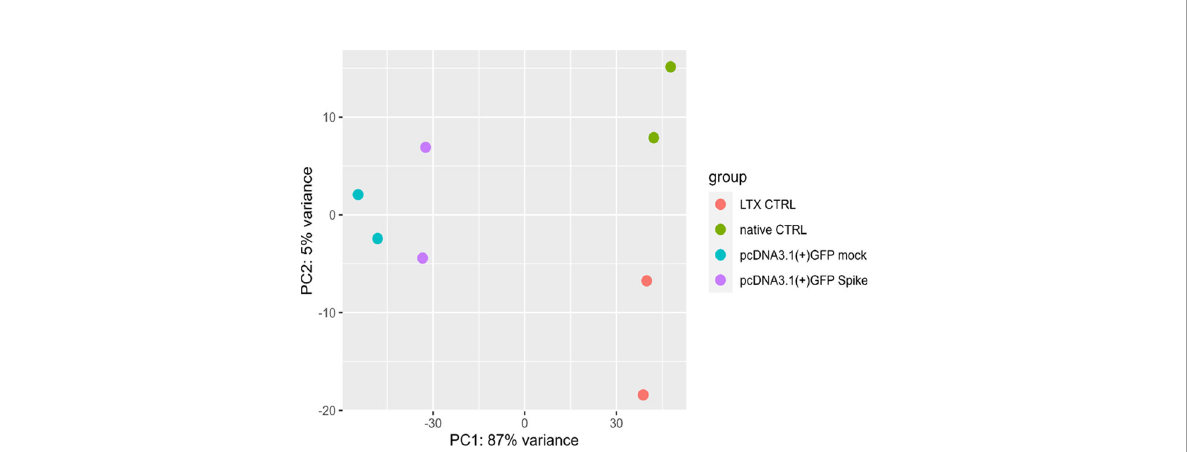
FIGURE 1 Principal component analysis (PCA). PCA of gene expression pro fi les in native (untreated) macrophage-like cells control (green, native CTRL), cells treated with only LTX reagent (orange, LTX CTRL), cells transfected with a pcDNA3.1(+)-N-EGFP plasmid (blue, mock) and cells transfected with S protein expressing plasmid